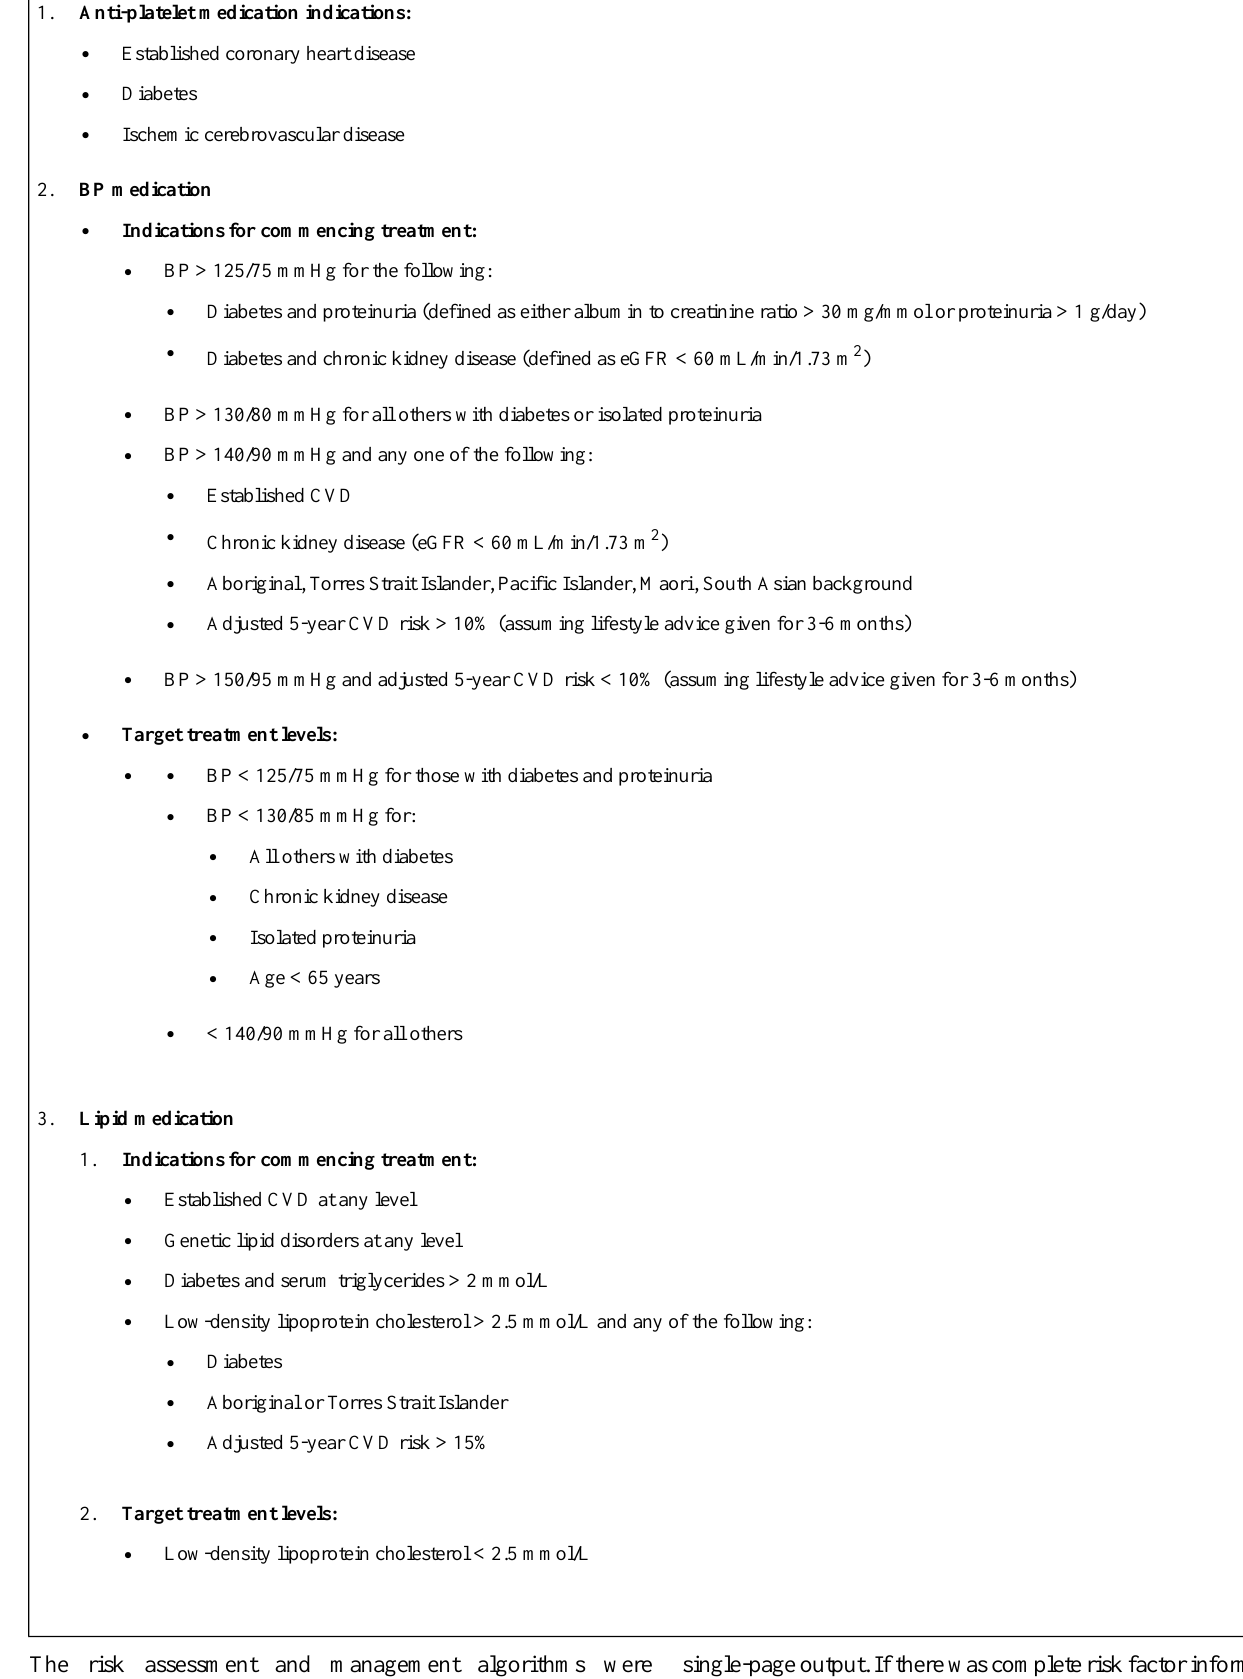
Textbox 2. Indications and target levels for CVD medication management programmed into the CDS tool Anti-platelet medication